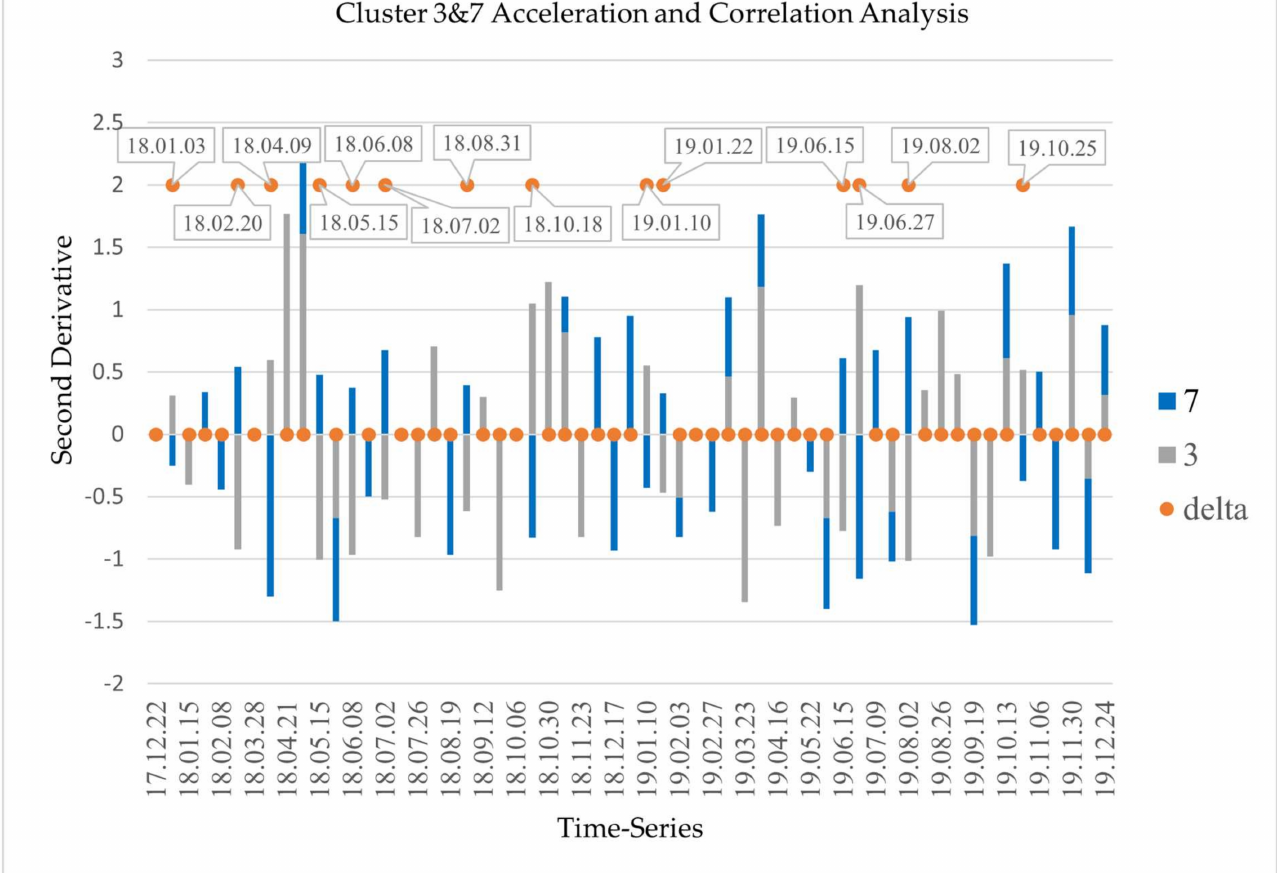
Figure 10. Inflection dates using uplift (cluster 3) and subsidence (cluster 7) (7: cluster 7; 3: cluster 3; delta: difference in sign of cluster 3 and cluster